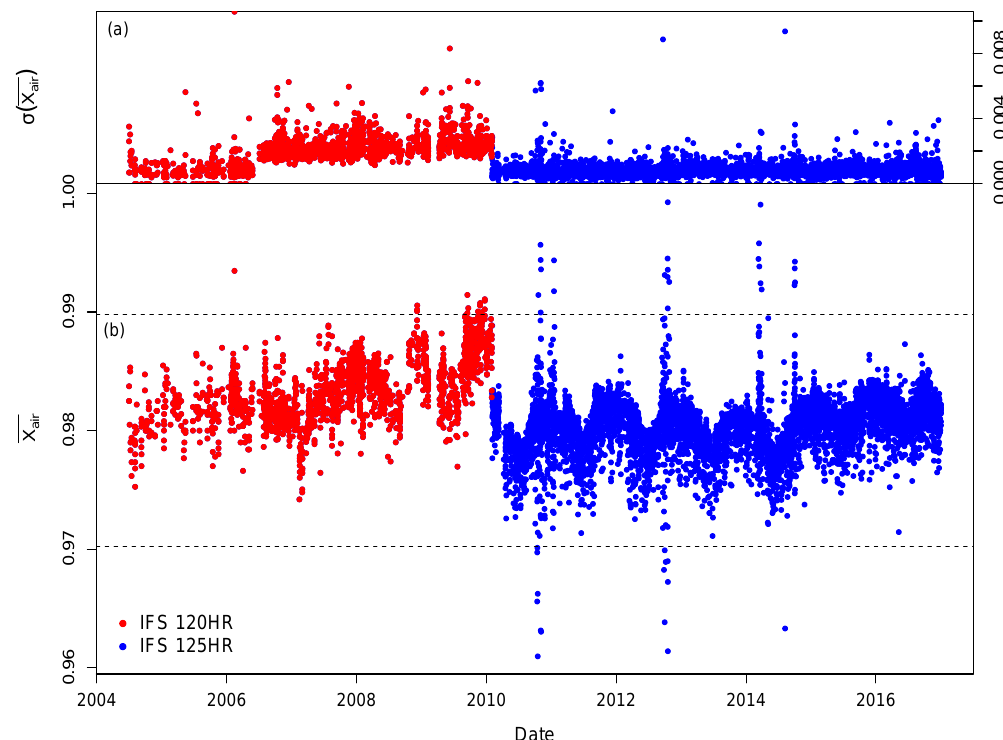
Figure 4. Time series of hourly means of X air (b) and SDs about them (a) retrieved from measurements made with both FTS instruments at